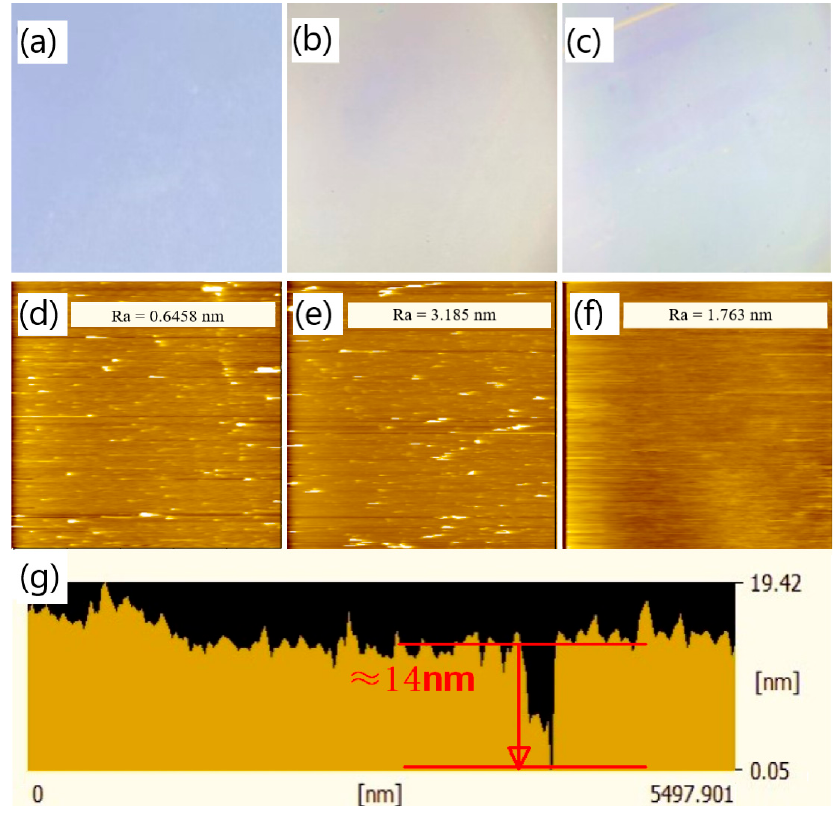
Figure 8. OM image of the surface of the PDA fi lm deposited on silicon dioxide substrate under the pH of 8.2 and the concentration of 1.5 mg/mL with a deposition time of ( a ) 2 min, ( b ) 10 min, and ( c ) 20 min; the AFM image of the surface of the PDA fi lm deposited on silicon dioxide substrate under the pH of 8.2 and the concentration of 1.5 mg/mL with a deposition time of ( d ) 2 min, ( e ) 10 min, and ( f ) 20 min; ( g ) the cross-sectional view of the AFM scanning of the surface of the PDA fi lm under the deposition time of 20 min.